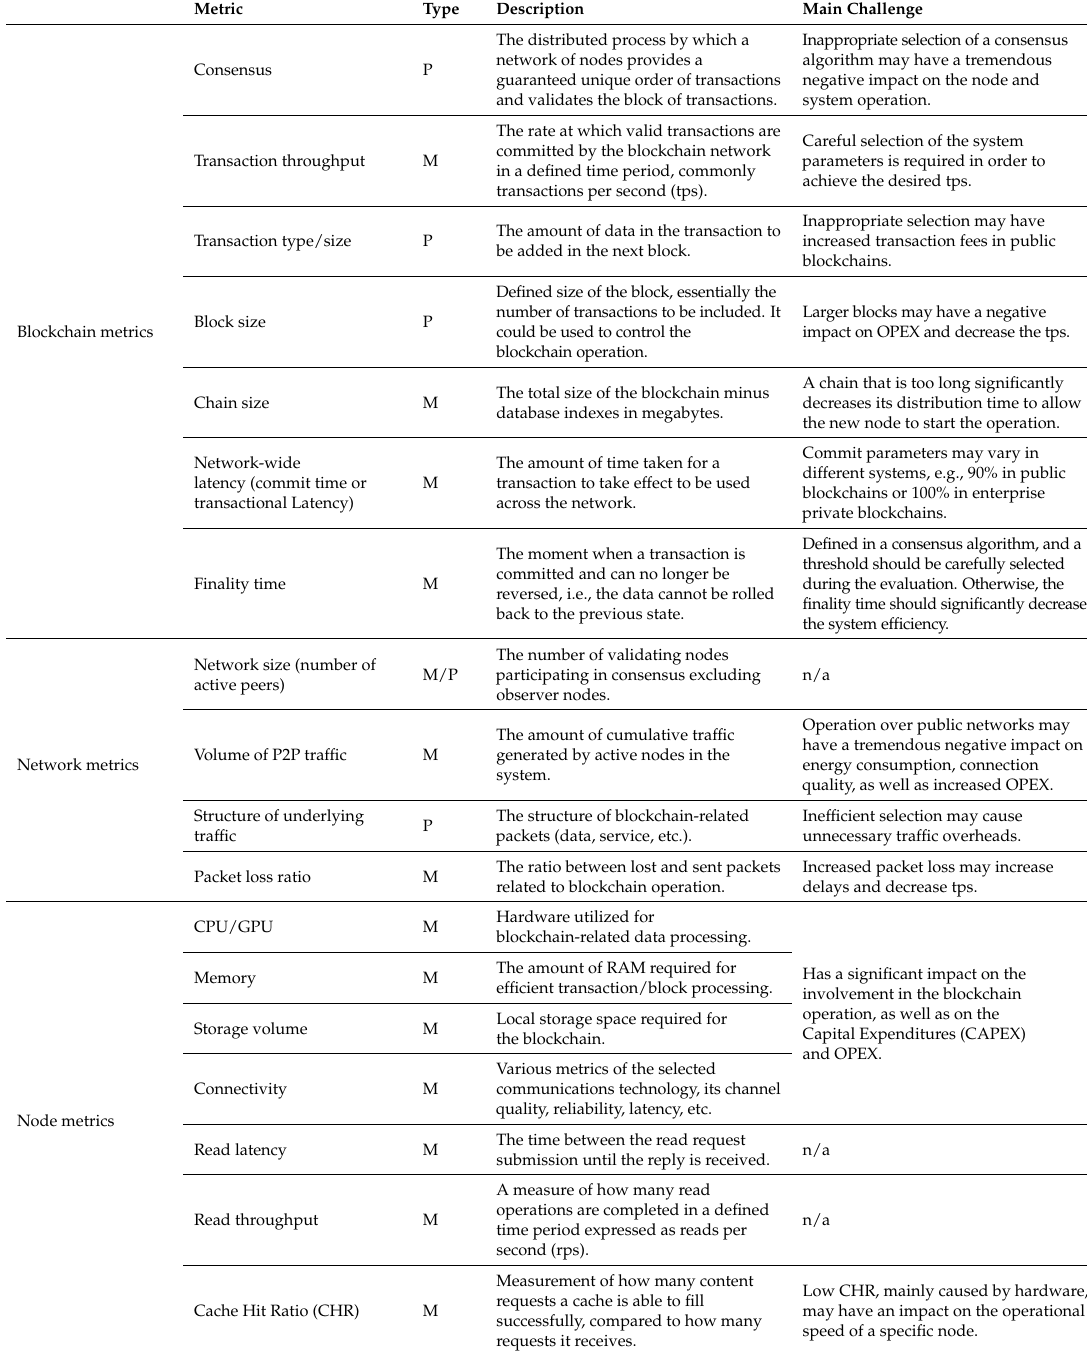
Table 1. Main blockchain performance evaluation parameters (P) and metrics